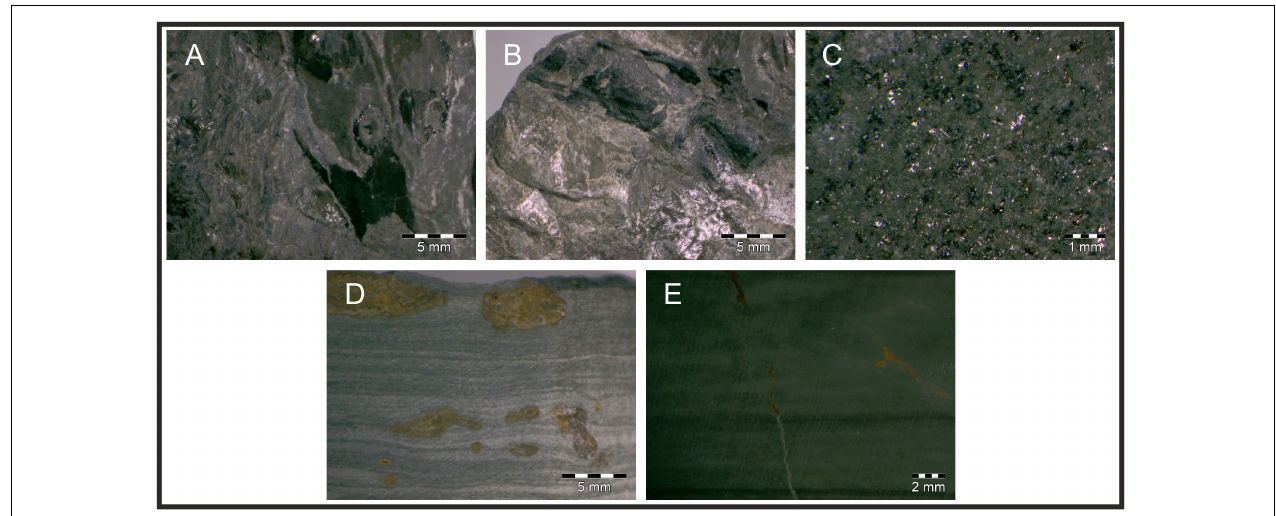
FIGURE 7 | Optical photomicrographs from Melbourne 1 (see Figure 5 for locations of samples and Table 2 for depths). (A) Sample SSK69728 A circular feature which is typical of a fossilized Stigmaria can be observed above a patch of organic carbon, (B) Sample SSK69729 showing a polished listric surface, (C) Sample